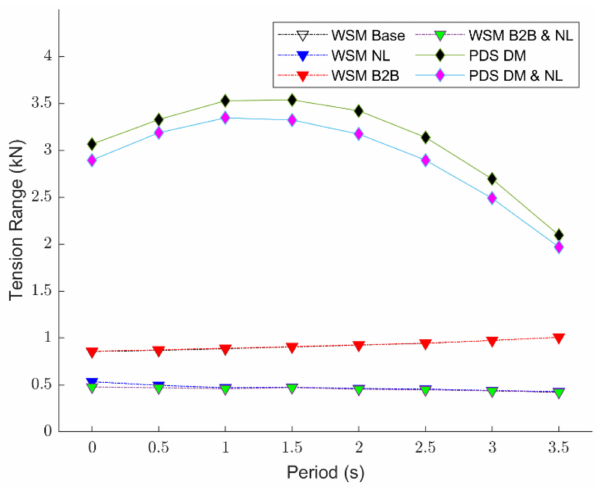
Figure 6. WEBS tether tension range in regular